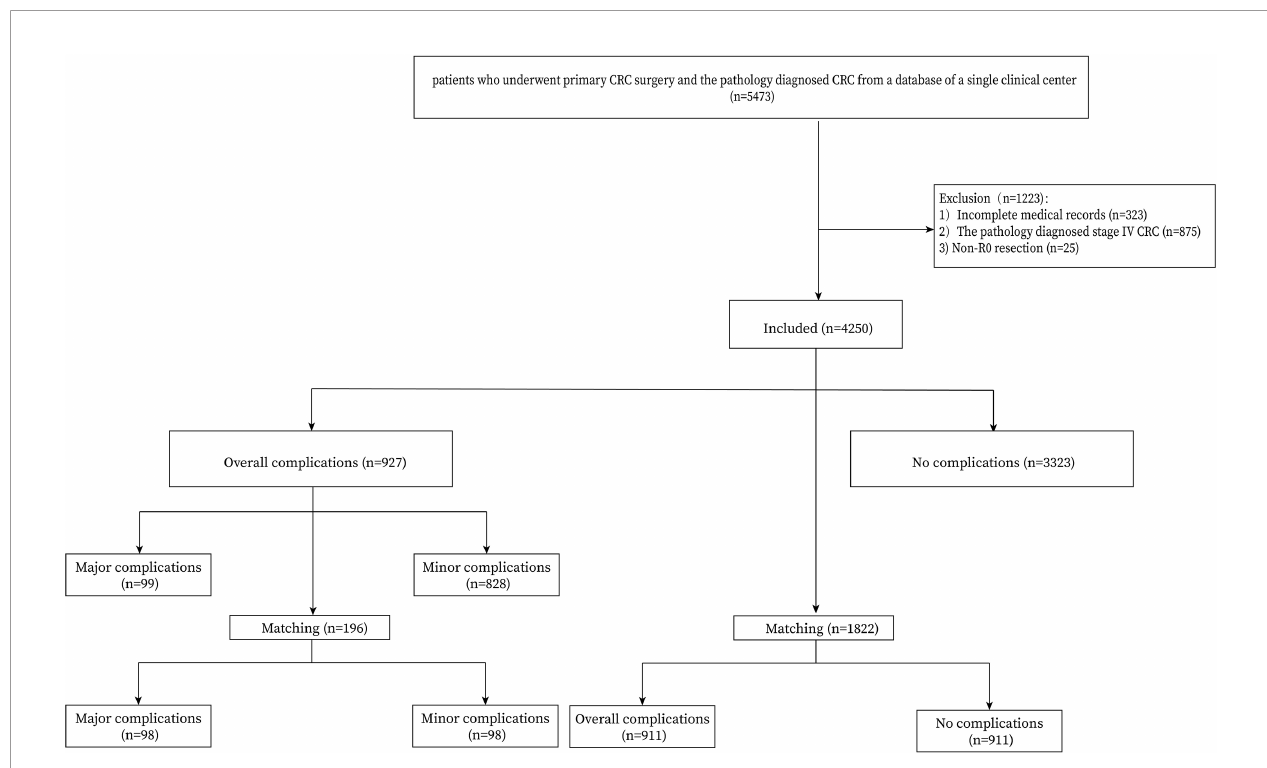
FIGURE 1 | Flow chart of patient